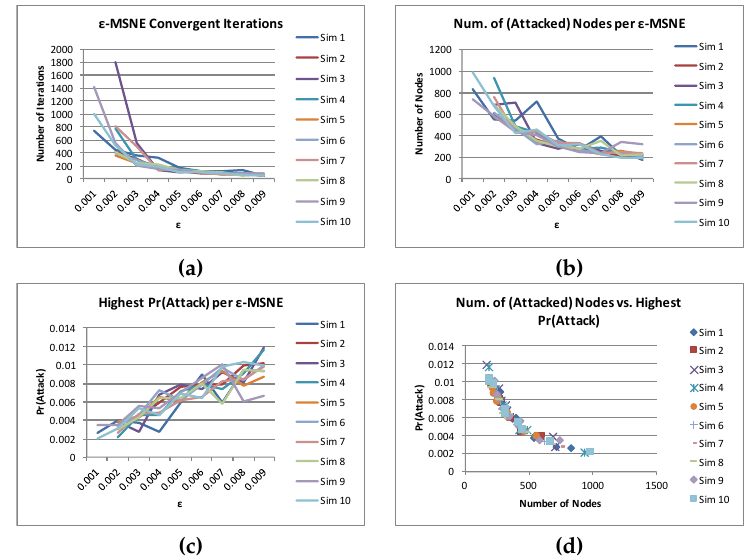
Figure 7. Attacker’s Strategy at (cid:101) -MSNE. The x -axis of the graphs ( a ), ( b ), and ( c ) represents the (cid:101) value and their y -axis represents the number of iterations until convergence (or 2000 iterations max) to some (cid:101) -MSNE, the number of nodes that are being attacked, and the highest probability of attack, respectively. The scatter plot in graph ( d ) shows the relation between the number of nodes that are being attacked and the highest probability of attack in x -axis and y -axis, respectively.